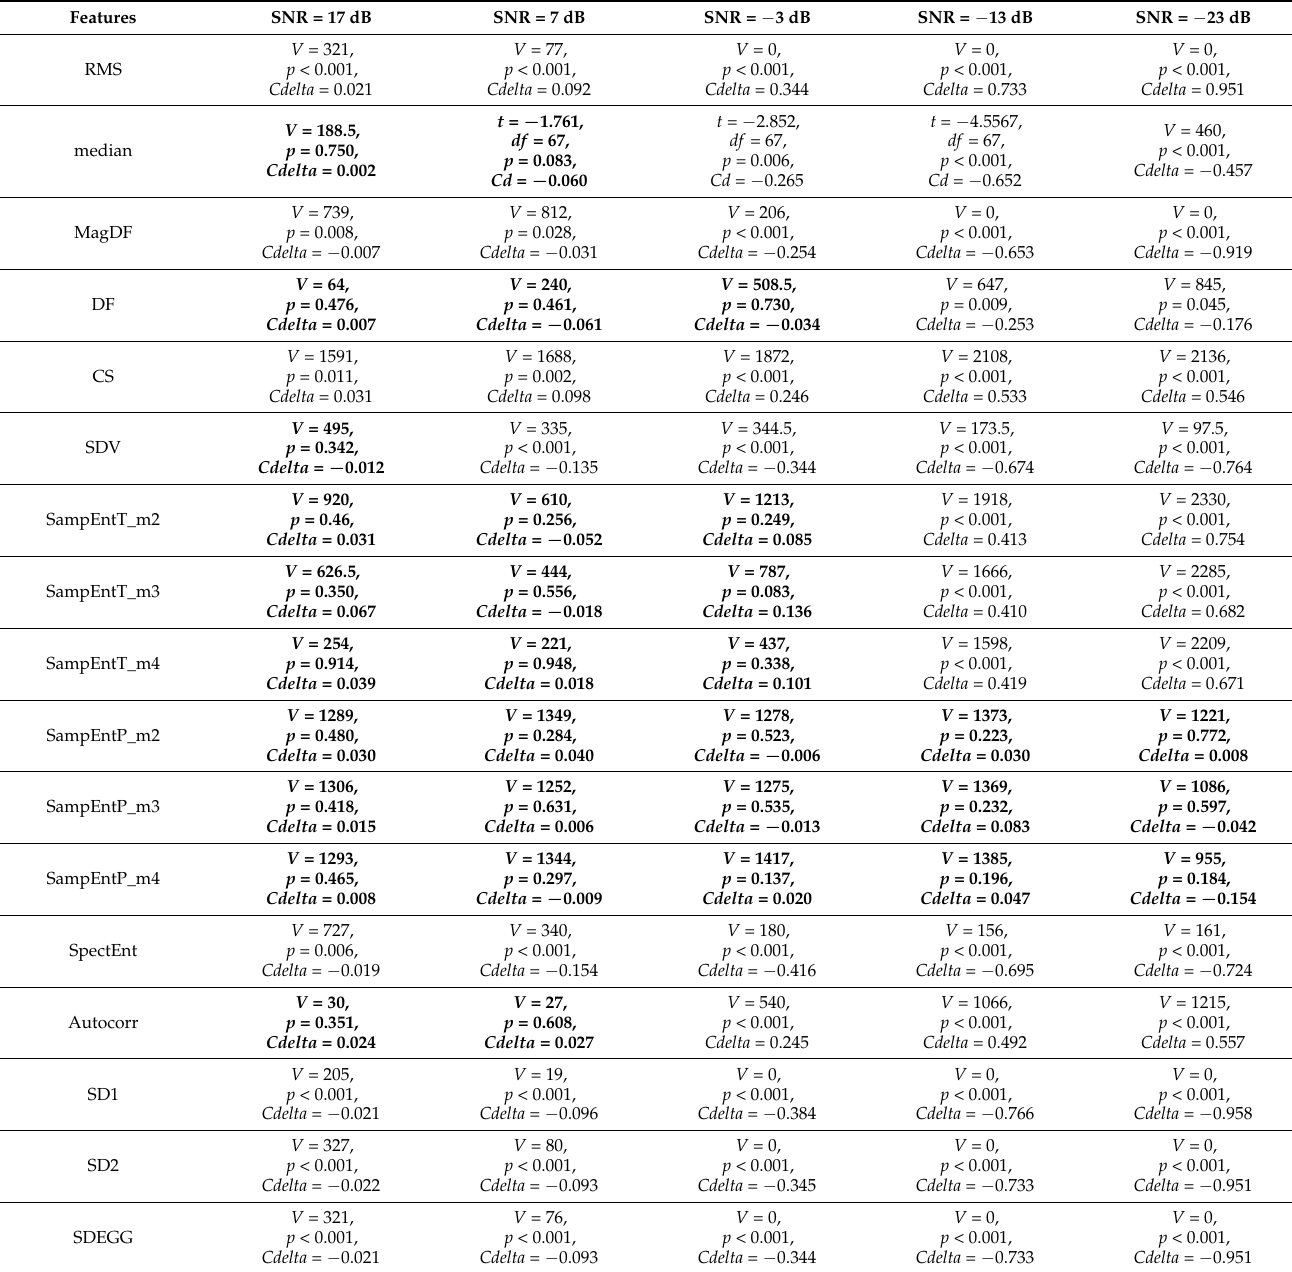
Table 2. Results of paired t -tests and Cohen’s d (for normally distributed data), as well as paired Wilcoxon’s Signed-Ranks tests and Cliff’s delta (for not normally distributed data) for comparison of non-noisy and noisy EGG-based parameters are presented. For testing normality, p was set at 0.05. Values with p > 0.05 (no significant difference due to the noise is observed, i.e., EGG-based features are robust to the noise levels) are highlighted in bold. SNR stands for Signal-to-Noise Ratio, V stands for V-statistics, p for probability, Cdelta for Cliff’s delta , Cd for Cohen’s d , t for t-statistics, and df for degrees of